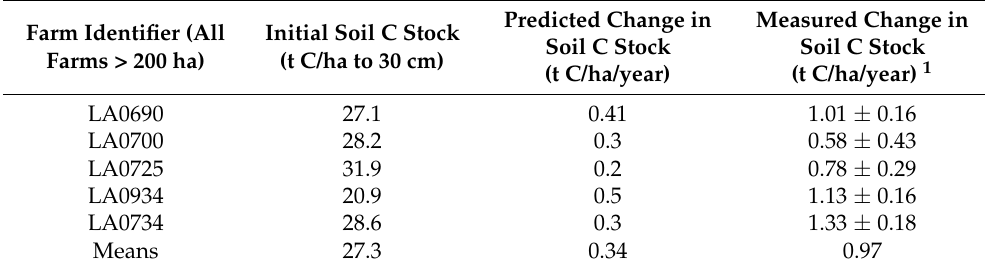
Table 3. Changes in soil carbon stock after a change from cropping to pasture in a 5-year on-farm trial in the Cowra Trough, NSW